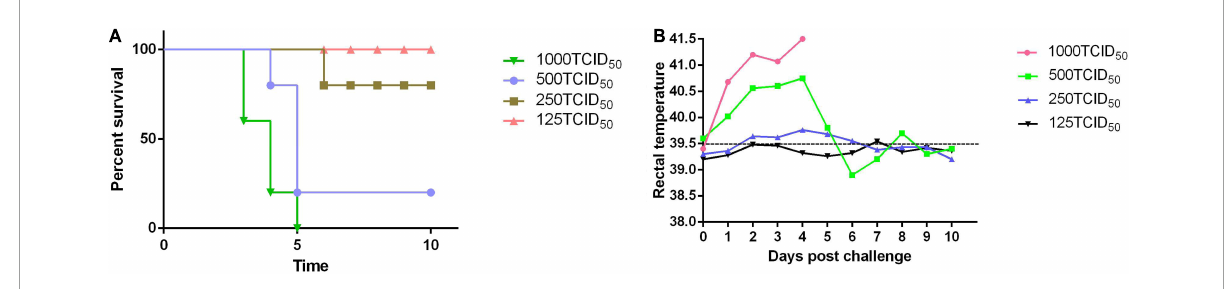
FIGURE3 The LD 50 of the PRV SD-2017 strain was measured in rabbits. Four groups of rabbits were inoculated subcutaneously with different doses of PRV (1000 TCID 50 , 500 TCID 50 , 250 TCID 50 , and 125 TCID 50 ). Mortality (A) and rectal temperature (B) were recorded during the 10-day observation